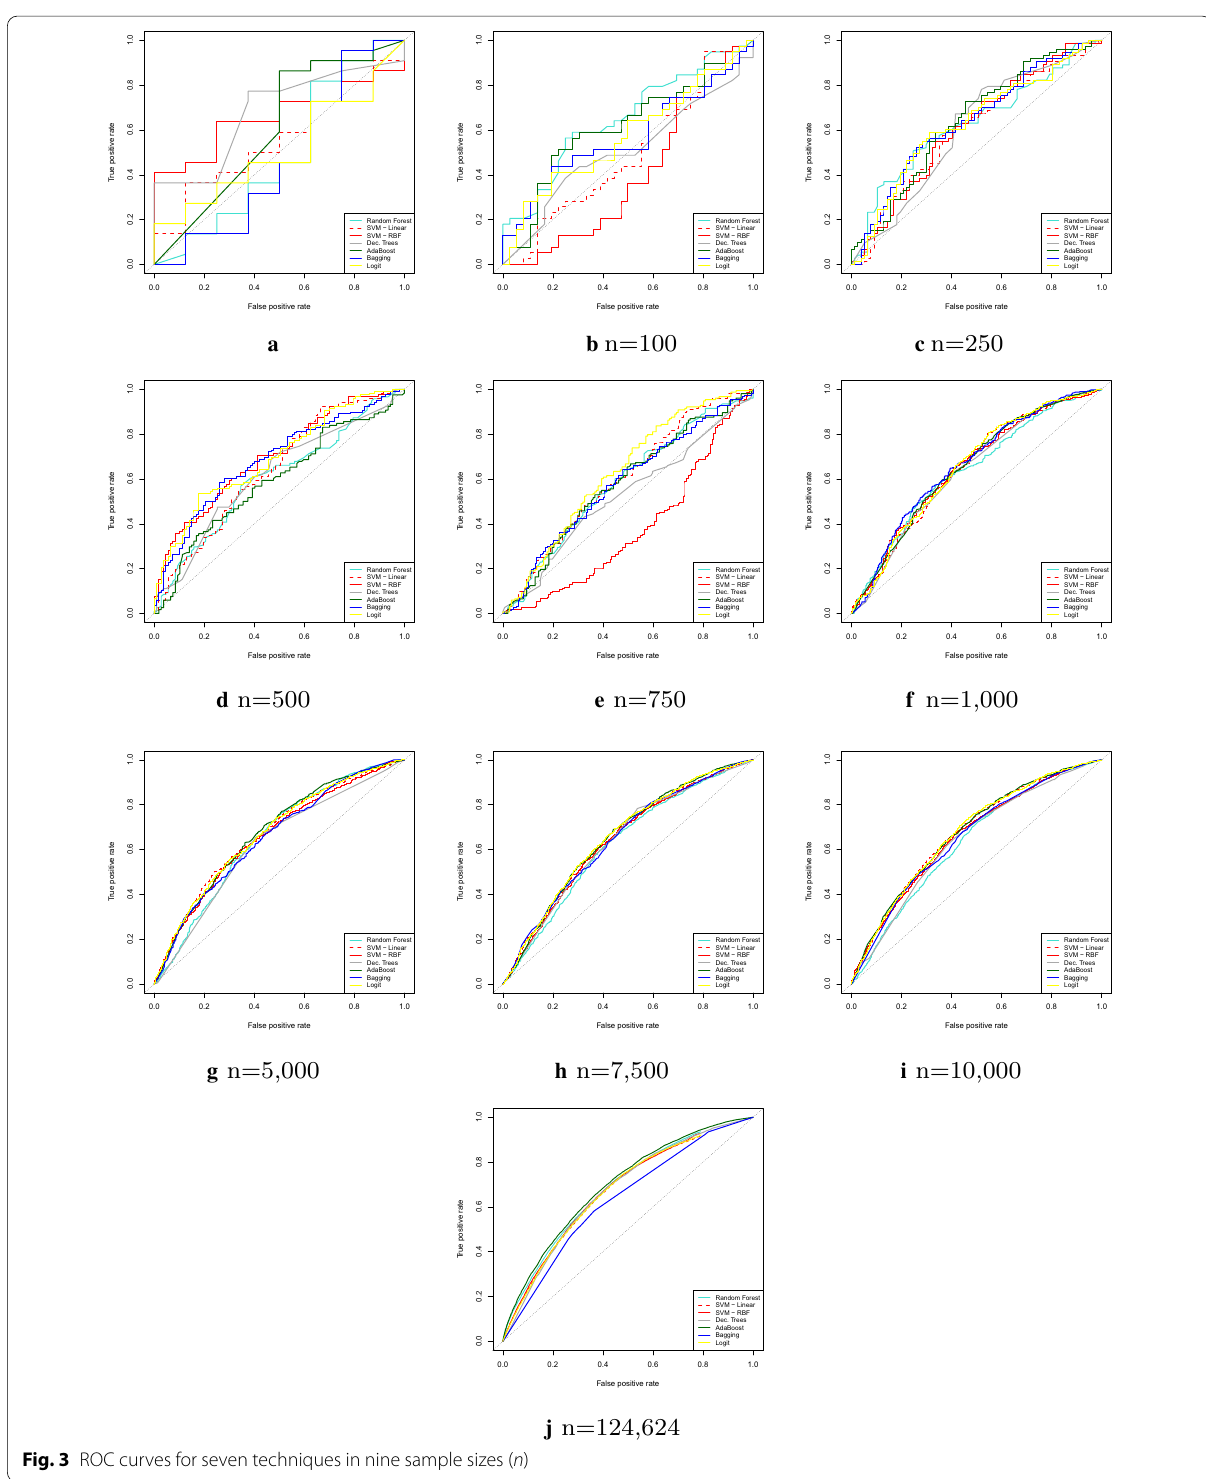
Fig. 3 ROC curves for seven techniques in nine sample sizes ( n